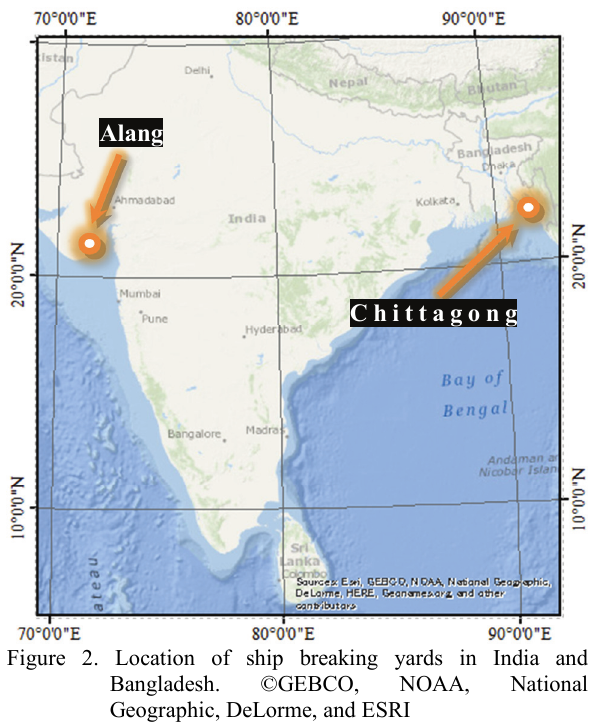
Figure 2. Location of ship breaking yards in India and Bangladesh. ©GEBCO, NOAA, National Geographic, DeLorme, and ESRI